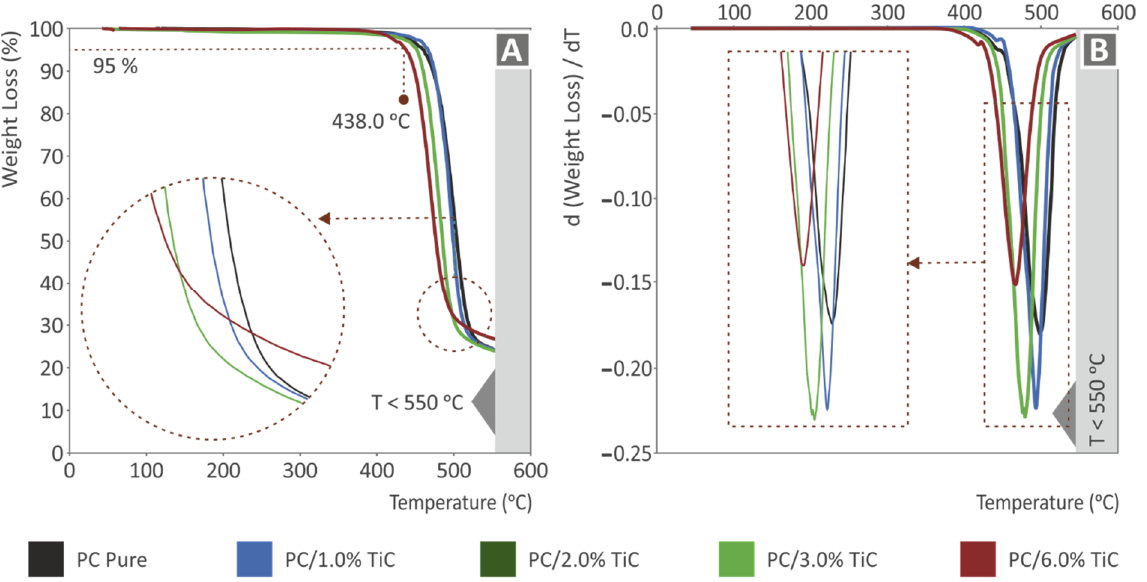
Figure 3. TGA: ( A ) weight (%) vs. temperature (°C) graph for all materials tested; ( B ) weight loss rate (dw/dT) vs. temperature (°C) graph for all materials tested.